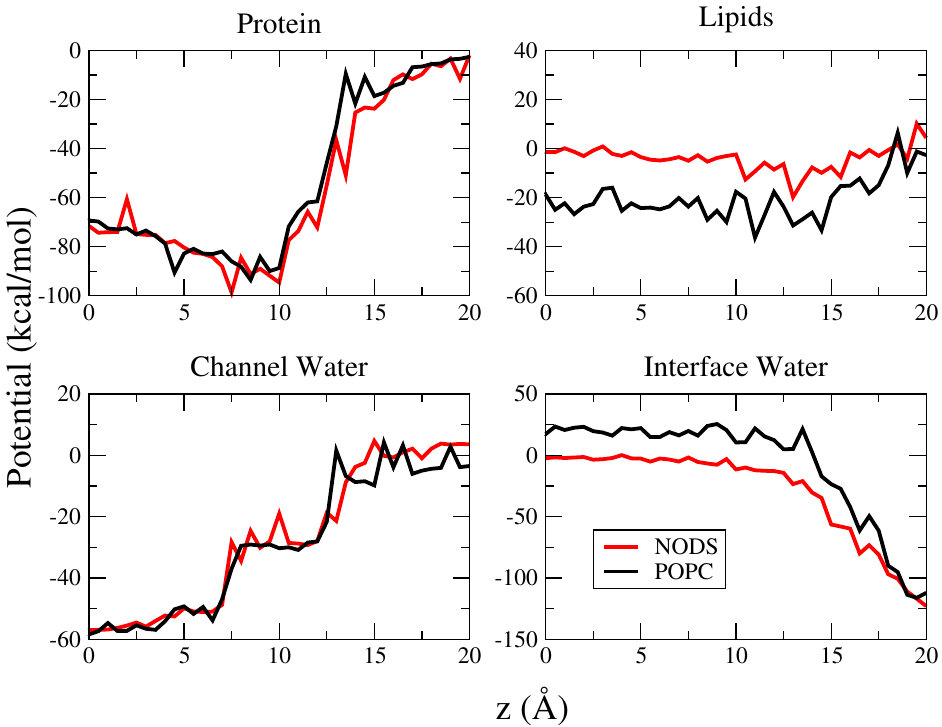
Figure 6. Potential energy acting on K + ion as a function ion positions in the gA channel. Interactions calculated include protein, lipid molecules, channel water and interfacial water. Red and black line represents POPC and NODS lipid